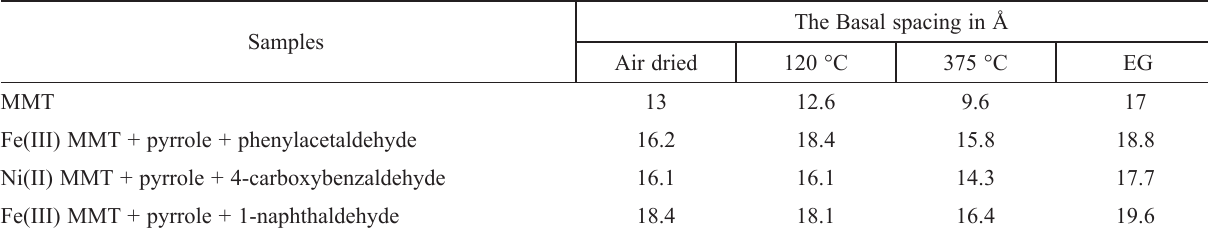
The Basal spacing in Å